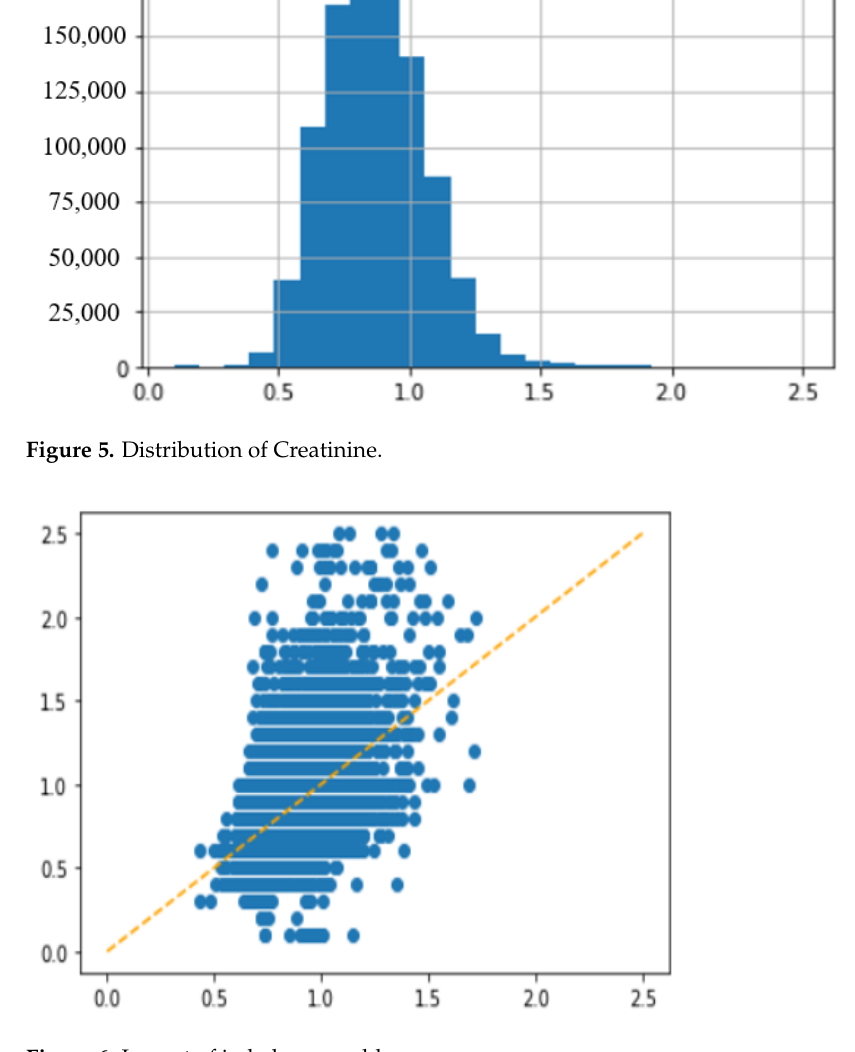
Figure 6. Impact of imbalance